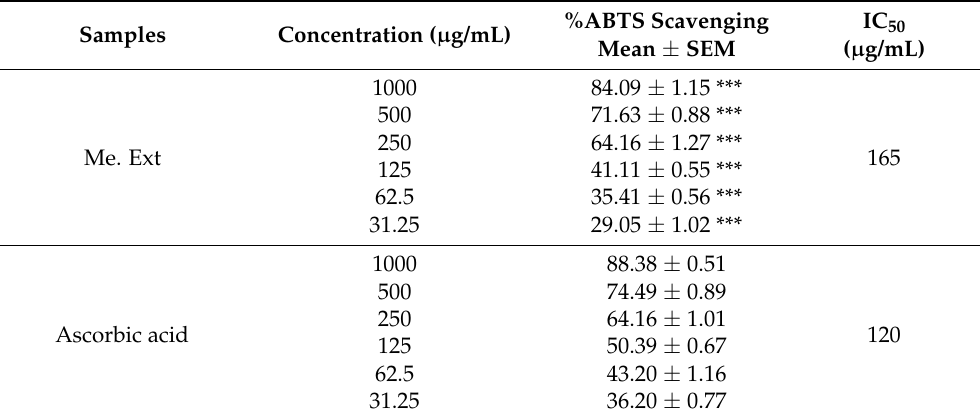
Table 6. Percent 2,2 (cid:48) -azinobis-3-ethyl benzo thiazoline-6-sulfonic acid (ABTS) free radical scavenging activity of root